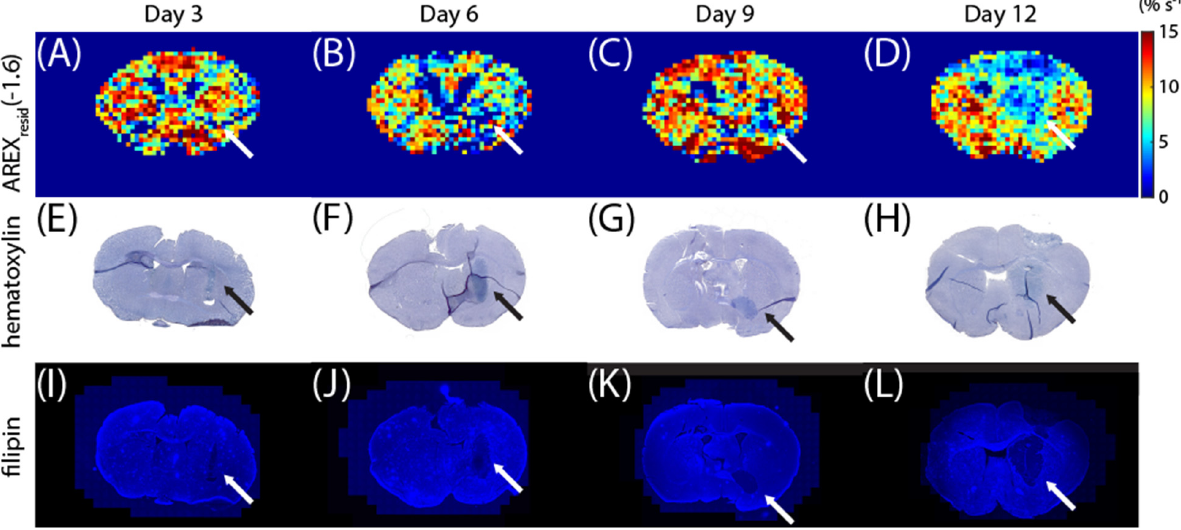
Figure 4. Images of AREX resid ( − 1.6) ( A – D ), hematoxylin staining ( E – H ), and filipin staining ( I – L ) on days 3, 6, 9, and 12. The arrows indicate the tumor regions.